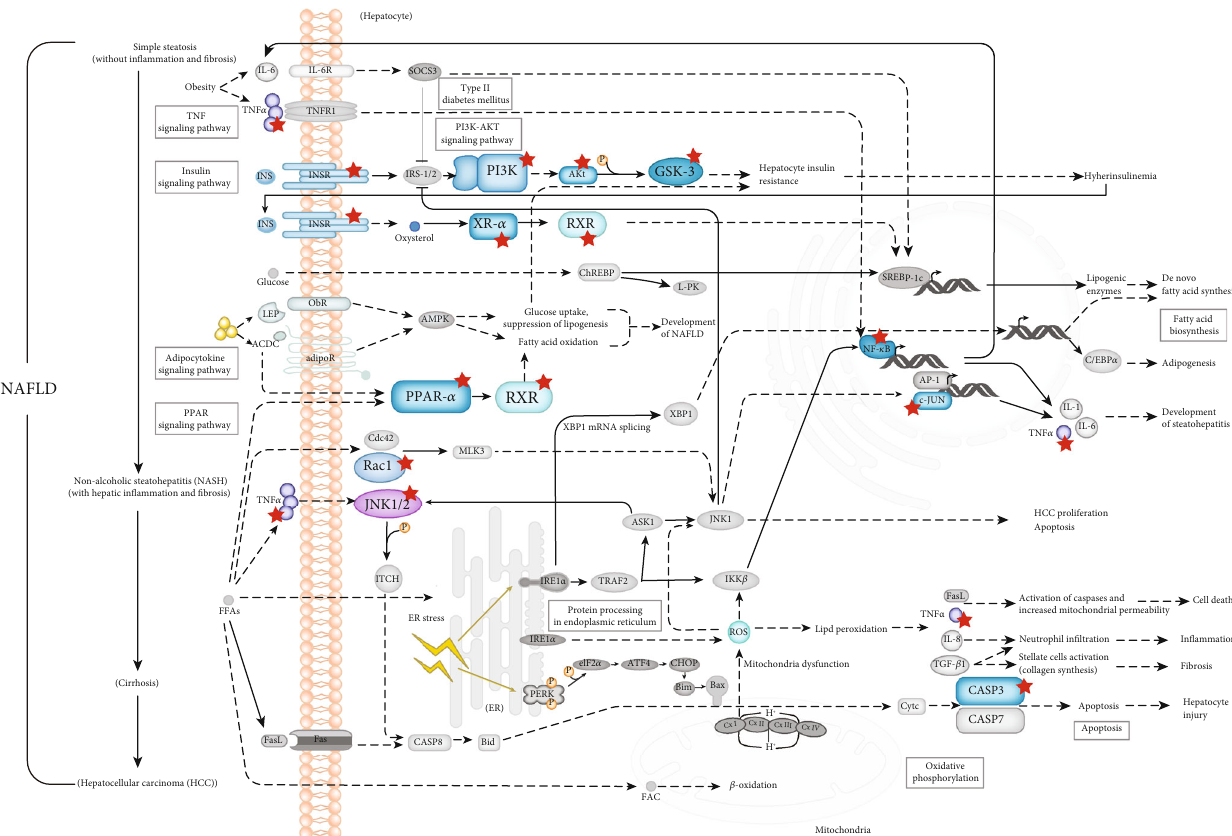
Figure 8: Stage-dependent progression of MAFLD. EZP-related targets are marked with red